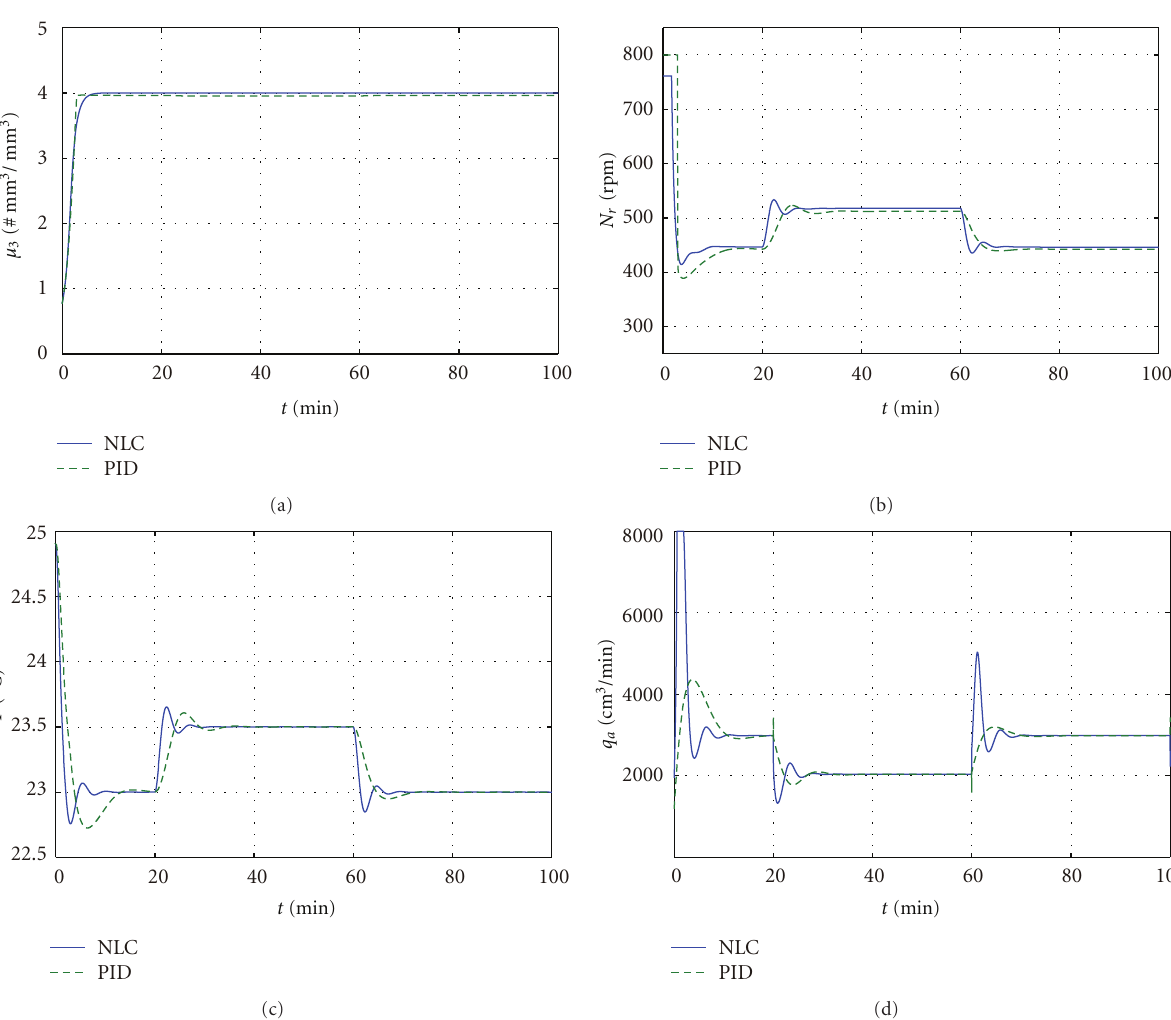
Figure 4: Closed-loop dynamic responses for the MIMO system when step changes in the crystallizer temperature are